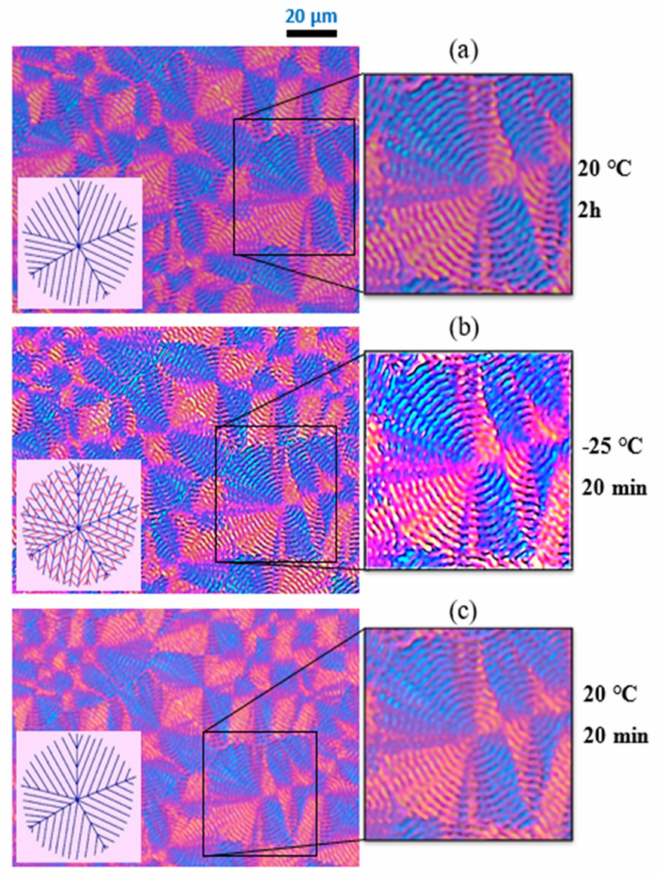
Figure 7. PLOM micrographs for the sample at the pseudo-eutectic point (MM W -BS 45 CL 55 ). The schematic models are inserted at the bottom left of the PLOM images: ( a ) Crystallization of the sample by fast cooling from the melt to 20 ◦ C (holding for 2 h). ( b ) Second step of crystallization by fast cooling from 20 ◦ C to − 25 ◦ C (holding for 20 min). ( c ) Heating the sample to 20 ◦ C at a 10 ◦ C/min rate. The blue lines in the schematic models display BS-rich lamellae, while the red lines represent CL-rich lamellae and the amorphous phase is represented by the pink background. Reprinted with permission from ref. [37]. Copyright 2018 American Chemical